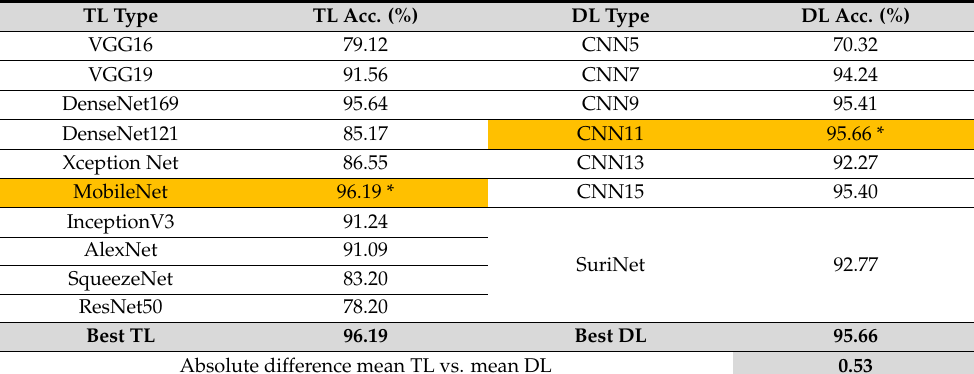
Table 3. TL systems vs. DL systems, background color represents the optimization